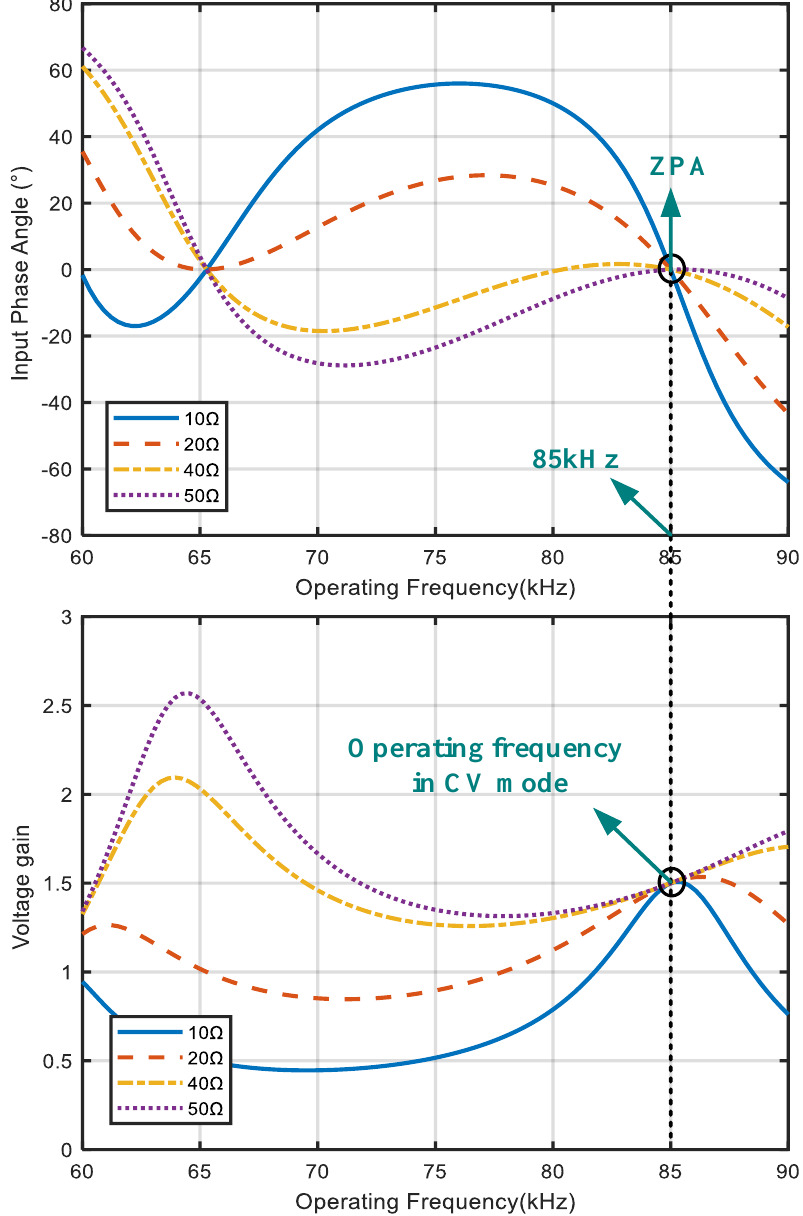
Figure 6. Voltage gain and phase of input impedance of the S/PS−compensated WPT system. Based on the above analysis, Figures 6 and 7 separately verify that the S/PS − compensated WPT system can realize CC and CV charging output unaffected by load changes at two different ZPA frequency points, respectively. Therefore, combining the above analysis, a frequency switching module can be added to the S/PS − compensated WPT system to satisfy the complete charging process of the